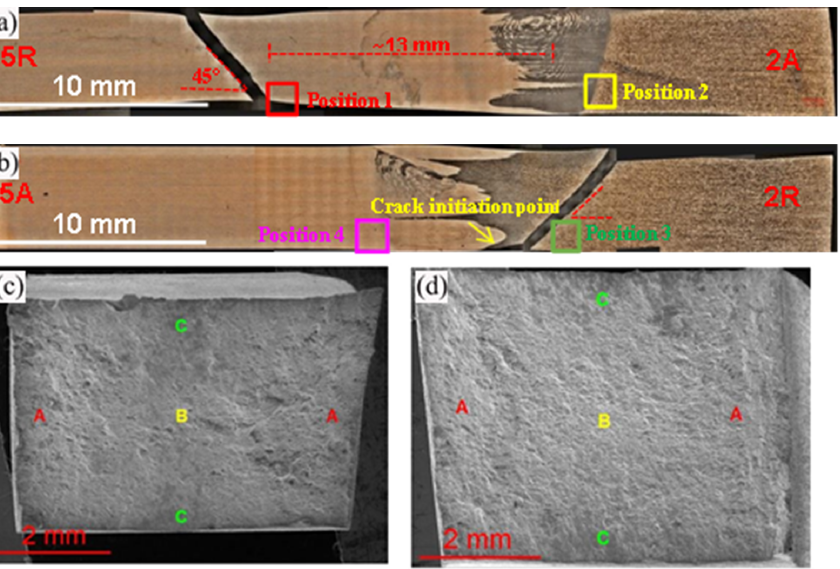
Figure 8. Fracture location and macroscopic fracture surface morphology of tensile specimens ( a , c ) 2A5R, ( b , d ) 5A2R.